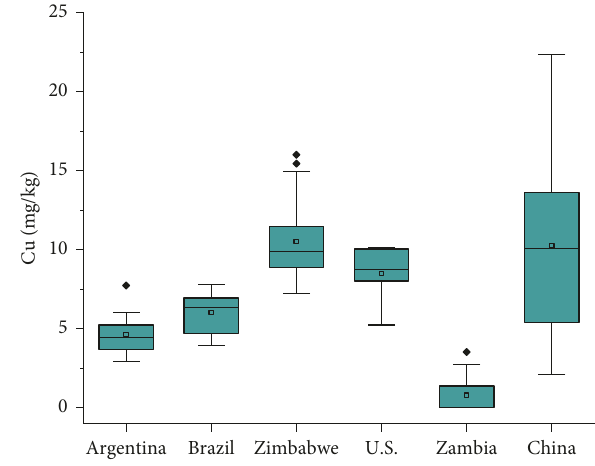
Figure 1: The box plots of Cu